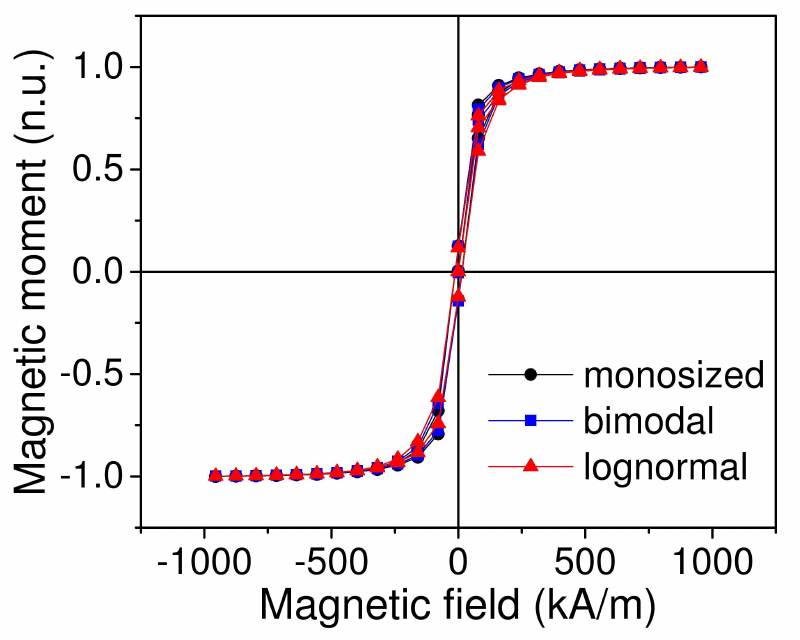
Figure 6. Simulated field dependence of magnetization of magnetorheological elastomers (MRE) with different types of size distribution of filler particles. Simulation was performed for a sample with 8.1% volume concentration of Fe.